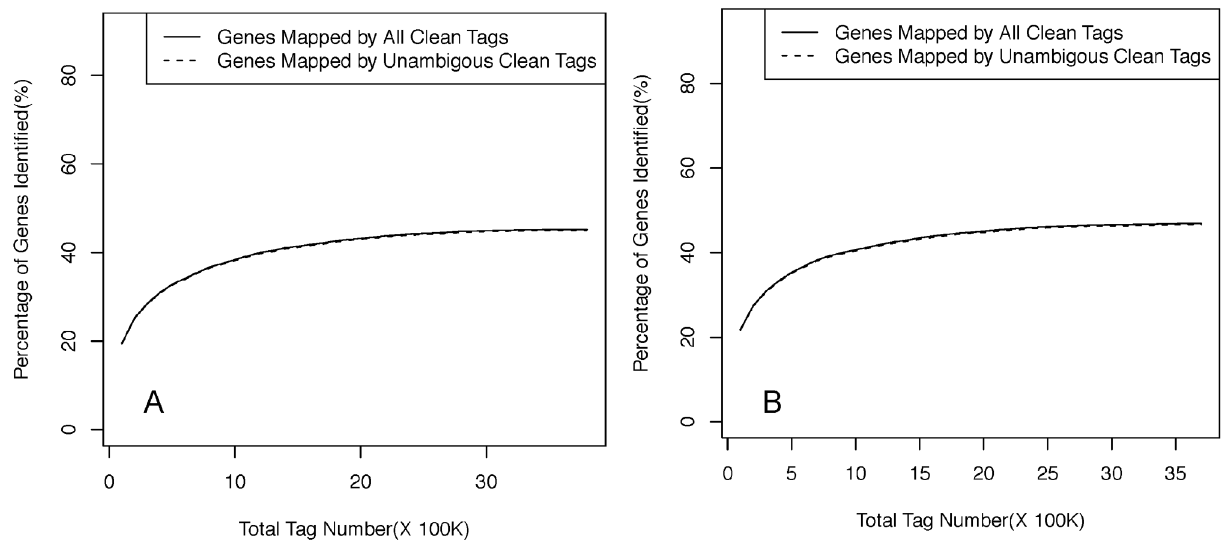
Figure 4. Percentage of total and unique clean tags that are mapped to the reference Verticilliumdahliae genome VDLs 17 in the non-germinated (A) and germinated (B) microsclerotium libraries in relation to the total number of tags. New unique tag (y axis) of VDMG-b and VDM libraries decreased as the Illumina sequencing increased (x axis).